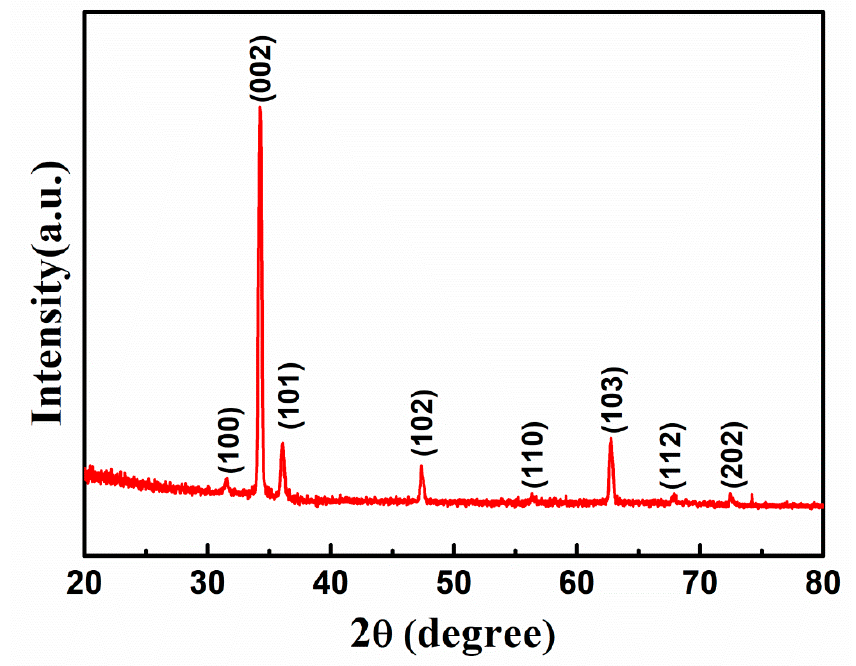
Figure 2. XRD patterns of ZnO nanorods grown on Al substrate.